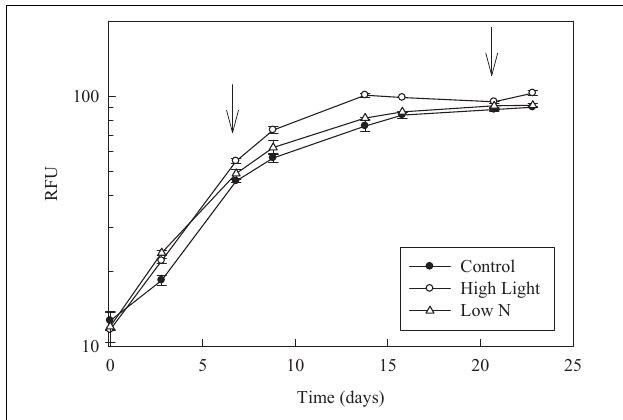
FIGURE 1 | Example growth curves for Porosira glacialis under the three growth conditions. Each point is the mean ± SD of triplicate cultures. Arrows represent the time cultures were sampled in exponential growth and early